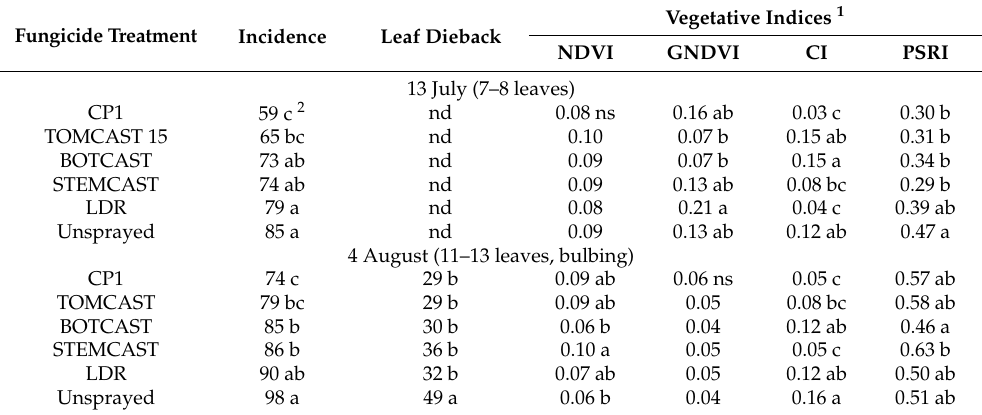
Table 3. Stemphylium leaf blight incidence, leaf dieback, and vegetative indices measured on onions in a fungicide application timing trial at the Muck Crops Research Station, Holland Marsh in